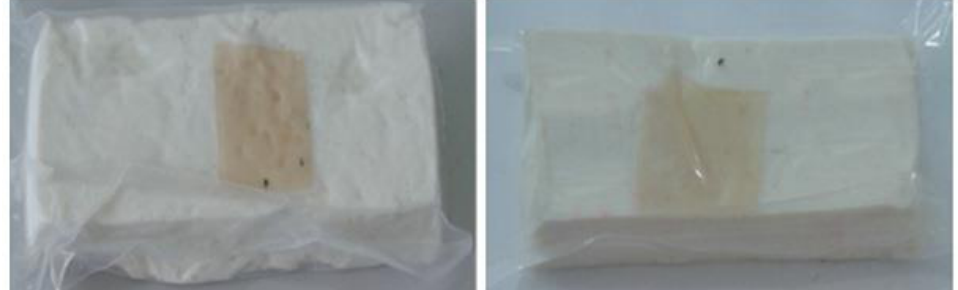
Figure 2. Color change in a pH-sensitive composite film produced from anthocyanins-loaded PVA– chitosan–gelatin for monitoring the spoilage of ricotta cheese during refrigerated storage: ( left ) 1 day ( right ) 7 days [73].